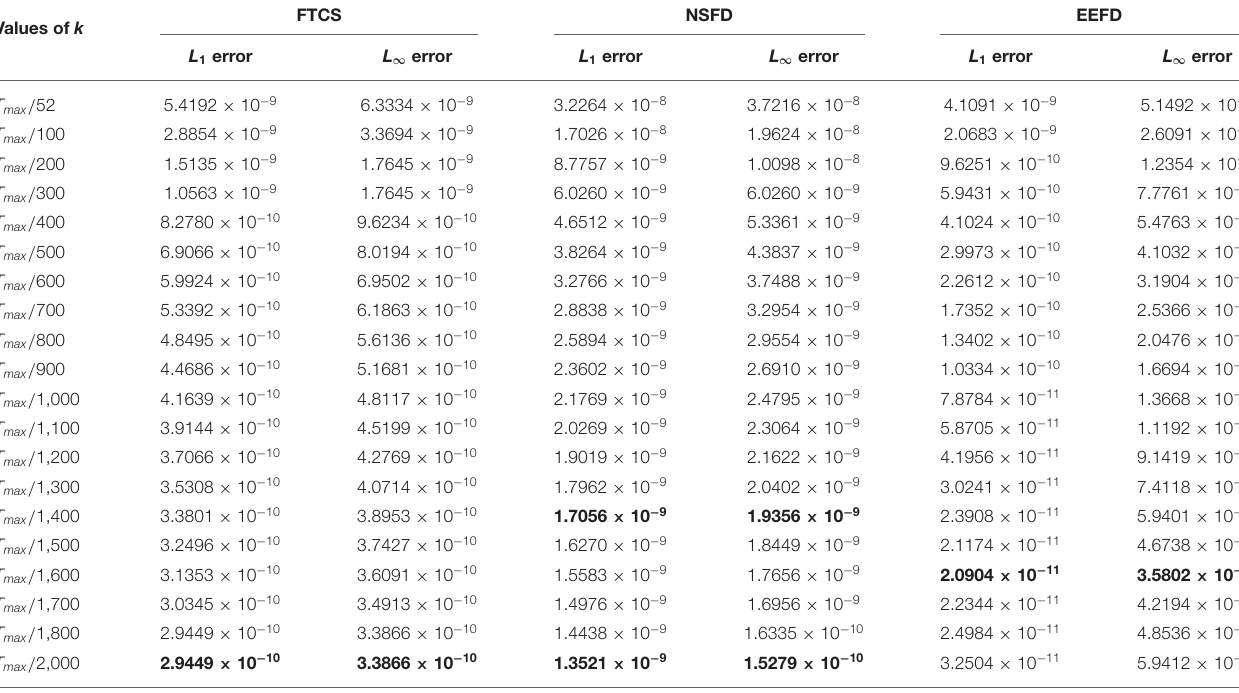
Bold values indicate the lowest errors.